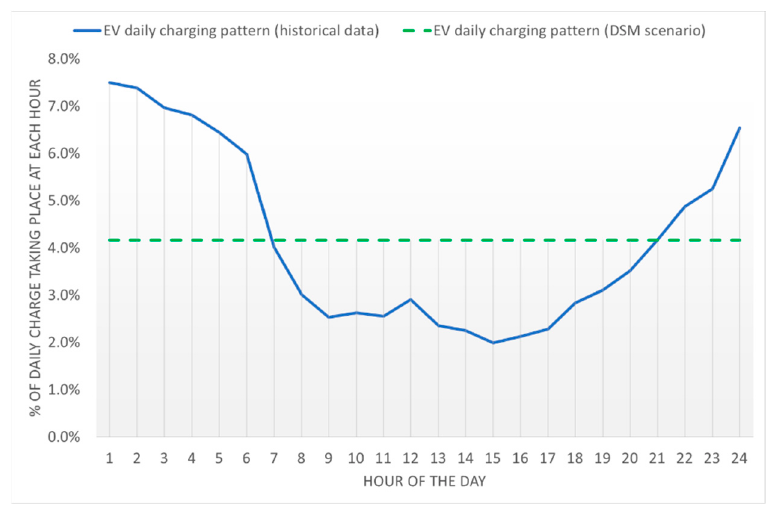
Figure 1. Daily EV charging patterns. Solid line = historical data (scenarios 2 and 3); dashed line = with demand side management (scenarios 4 and 5).